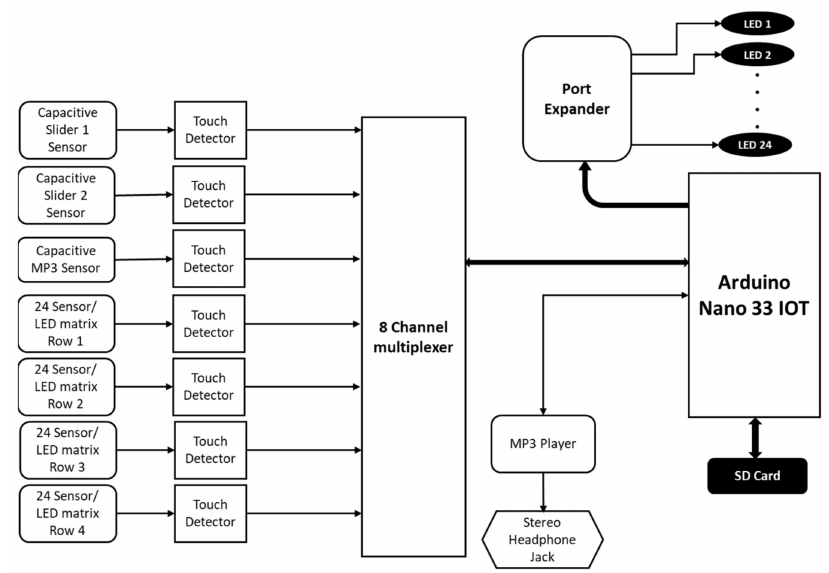
Figure 4. Schematic block diagram of the underlying technological layer in Figure 3b. All in- put/output devices are mapped to a specific location on the artifact. The selection of required switches/LEDs can be altered through the control program. This will allow an artisan the license to alter and shape the top layer to suit each patient’s personality as shown in Figure